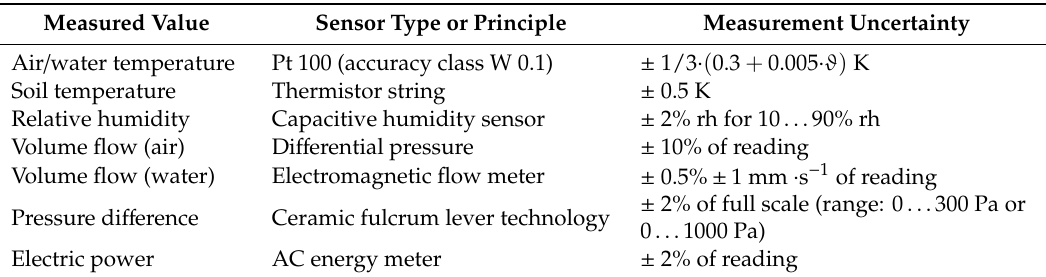
Table 2. Measurement devices and related